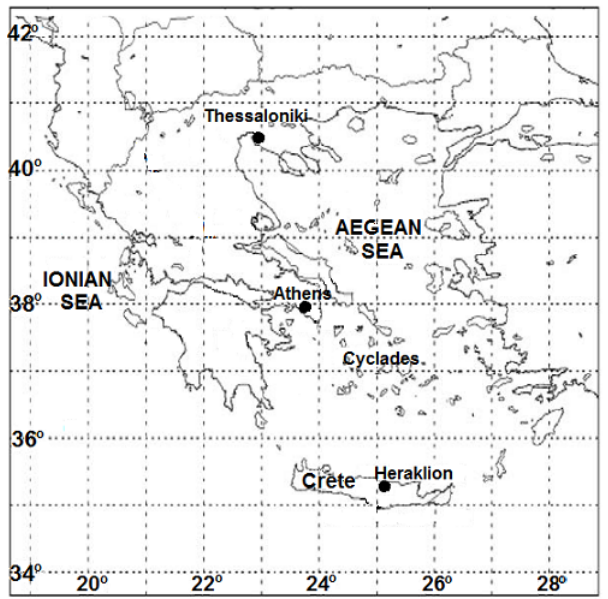
Figure 1. The map of Greece showing the three sites that are the focus of this study: Athens, Thessaloniki and